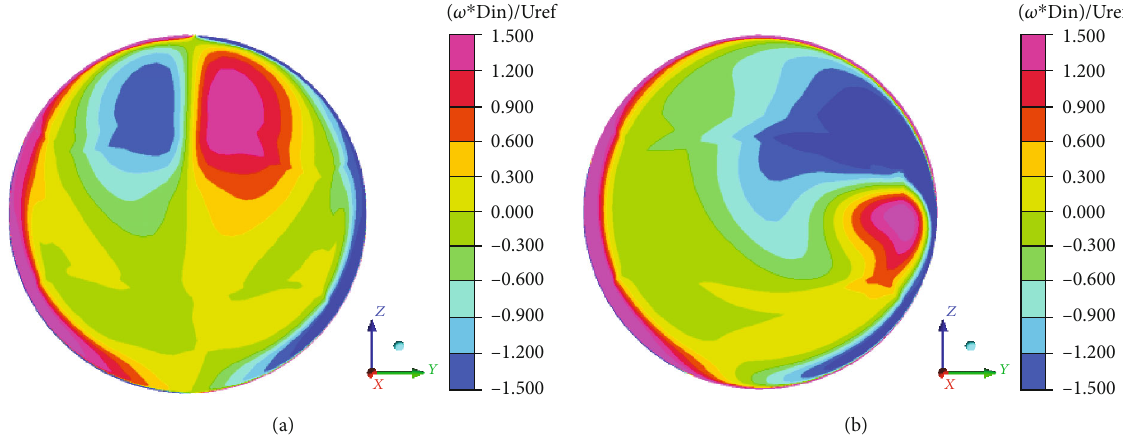
Figure 6: The vorticity distribution on the